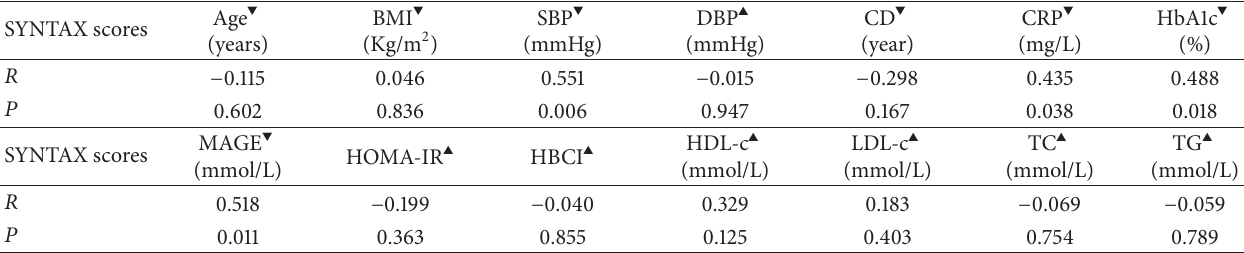
Table 2: Linear correlation analysis between SYNTAX scores and relative factors in group C.